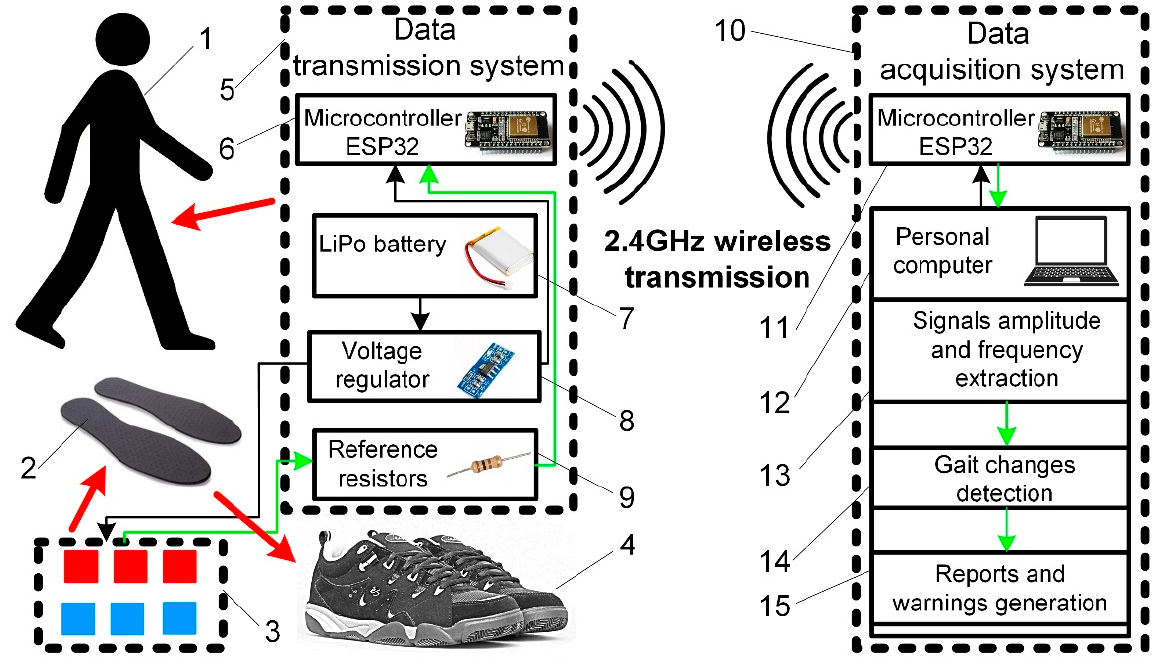
Figure 3. Experimental setup: 1; potential patient, 2; shoe linings, 3; feet sensors, 4; shoes, 5; data transition system, 6; microcontroller, 7; battery, 8; voltage regulator, 9; reference resistors, 10; data acquisition system, 11; microcontroller, 12; personal computer, 13; parameters extraction algorithm, 14; gait changes detection algorithm, 15; reports and warnings generation function. Black lines represent power supply lines, and green represent data